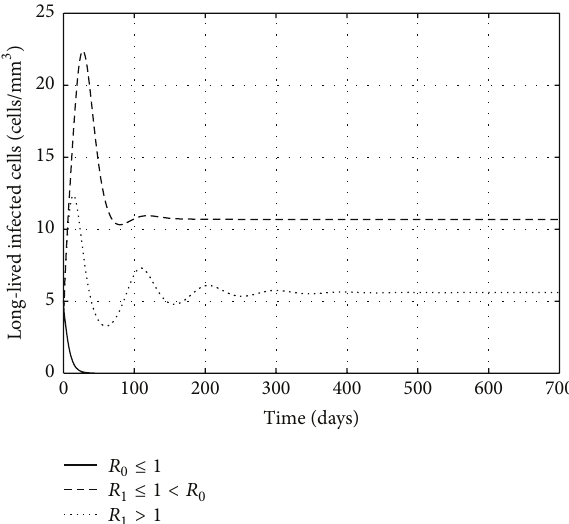
Figure 1: The concentration of uninfected CD4 + T cells for model (104).